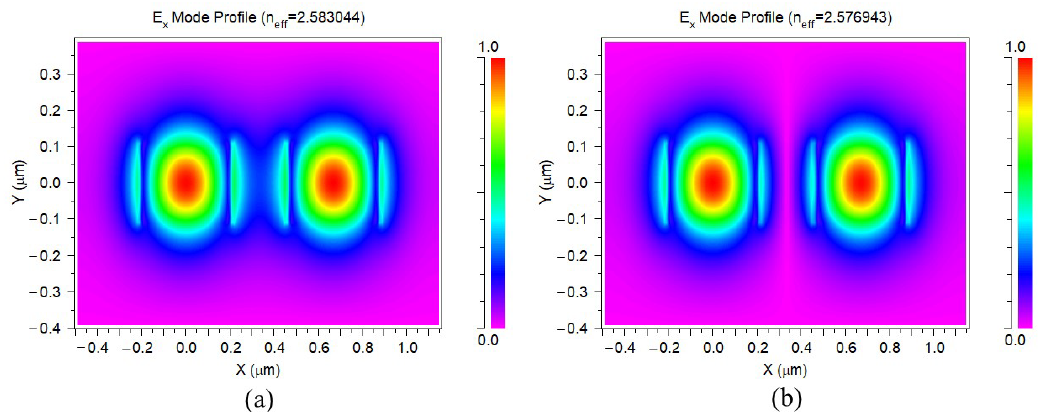
Figure 2. T he schematic drawing for the MZDC structure.